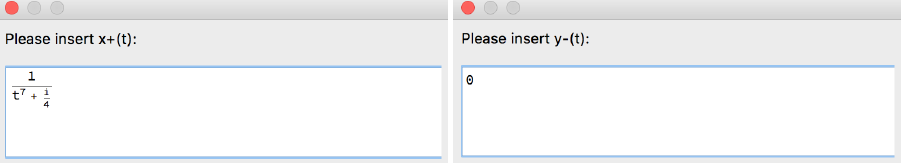
Figure 22. Part of the structure of the [SInt] algorithm corresponding to the input of x + and y − .